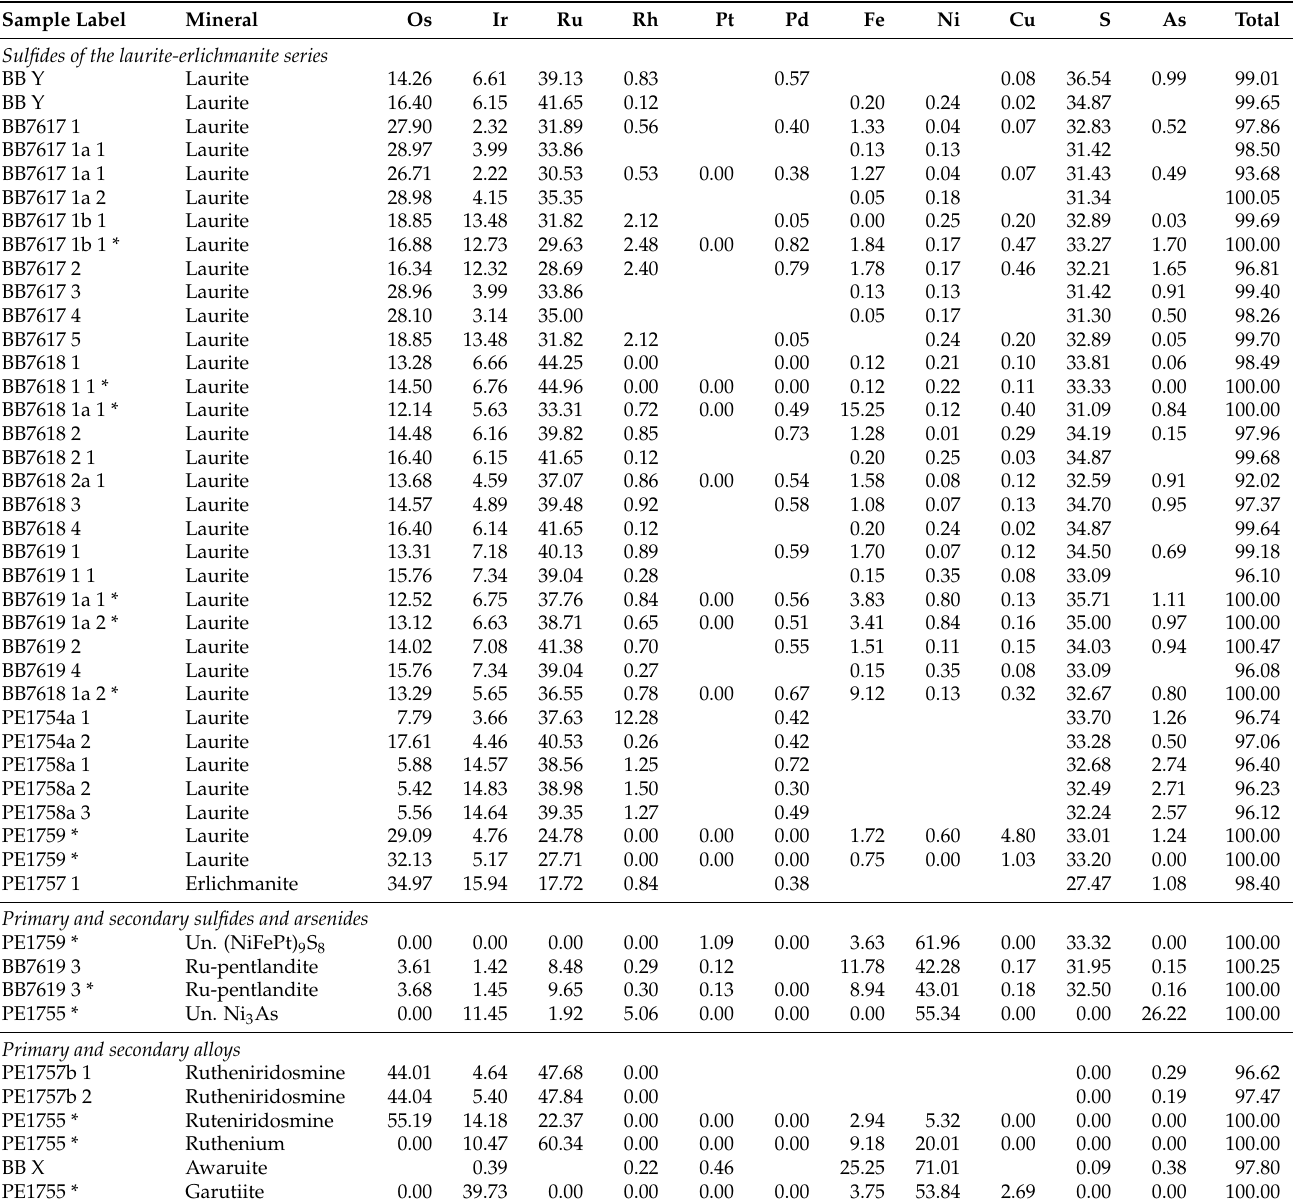
Table 7. Electron microprobe analyses (wt%) of platinum-group minerals (PGM) in podiform chromitite of the Kraka mantle